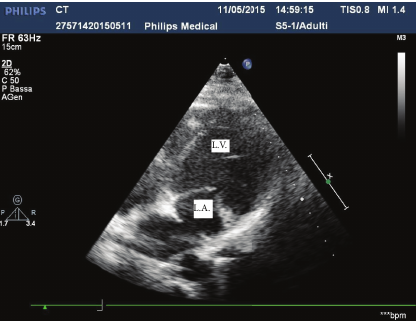
Figure 2: Four-chamber view. Inside the left atrium there is hyperechogenic structure. L.A.: left atrium; L.V.: left